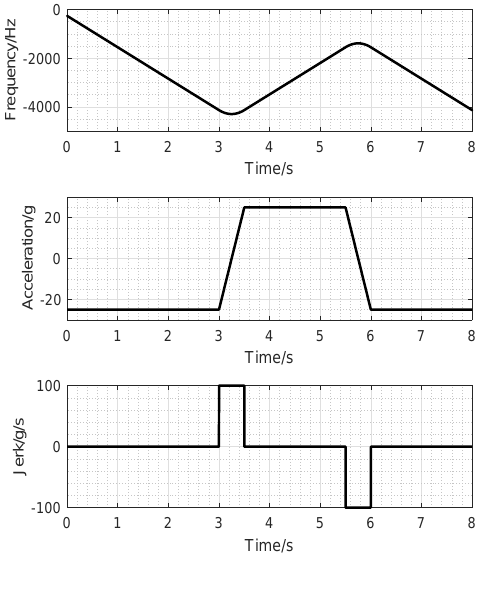
Figure 1. Highly dynamic signal